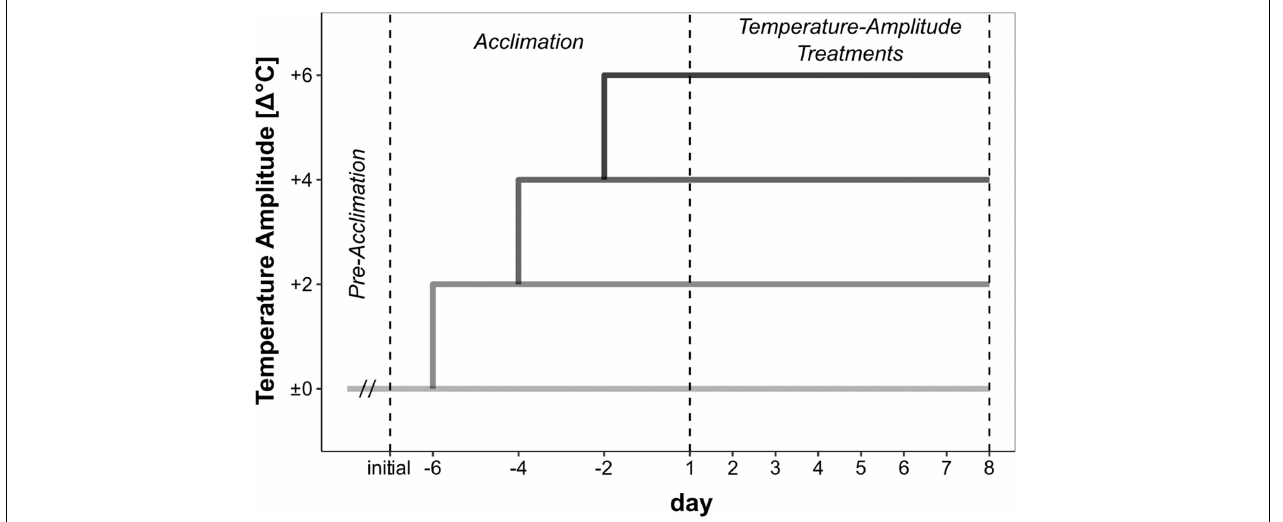
FIGURE 2 | Set-up of the temperature-amplitude experiment with Saccharina latissima . Pre-acclimation phase varied between the sampling sites due to logistic constraints. During the acclimation phase, the control temperature ( (cid:49) ± 0 ◦ C) was increased by 2 ◦ C every second day to reach the temperature-amplitude treatments ( (cid:49) +2– (cid:49) +6 ◦ C). Sampling for biochemical analyses was conducted on day 8 of the temperature-amplitude treatments.